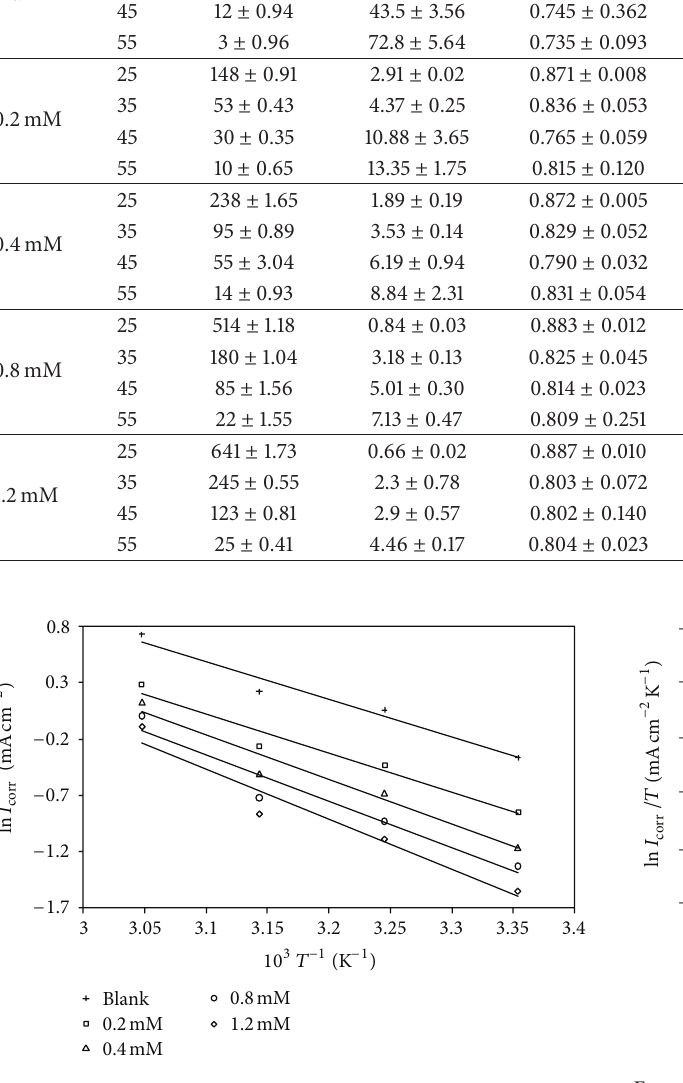
Figure 13: Arrhenius plots ln 𝐼 different concentrations of harmane.